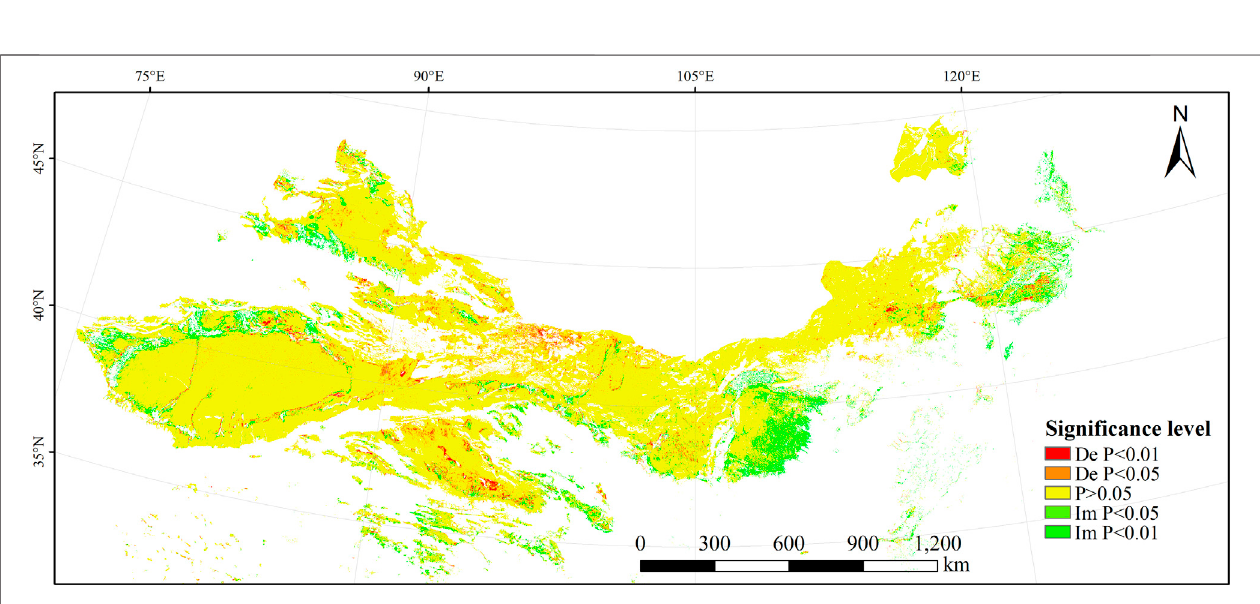
FIGURE 5 | Spatial distribution of statistically signi fi cant changes in the annual average normalized-difference vegetation index (NDVI) for the six desert types in northern China from 1998 to 2015. De and Im represent signi fi cantly decreasing and increasing NDVI, respectively, and P represents the signi fi cance level.